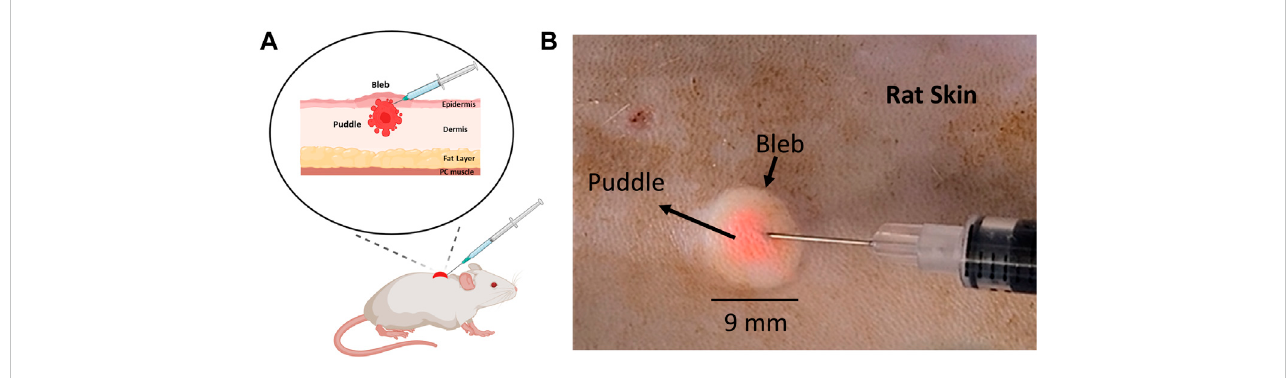
FIGURE 1 Location of the injected cargo (puddle) in relation to the injection bleb post ID injection. (A) A schematic diagram of a rat skin model indicating the location of the puddle relative to the bleb. (B) 100 µL ID injection of 3 µm fl uorescent particles in rat